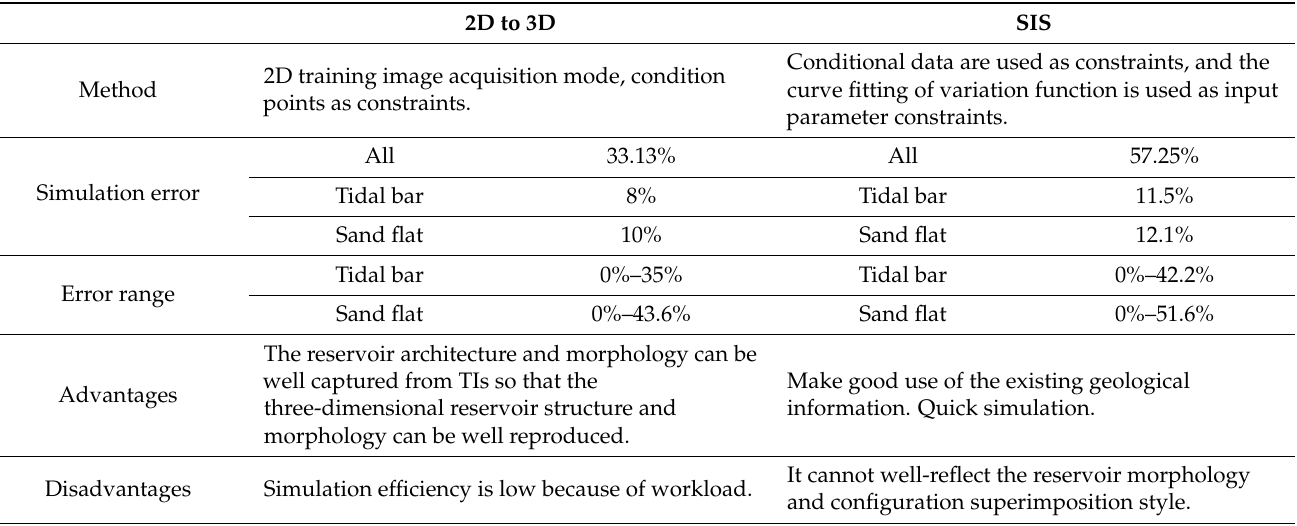
Table 1. Comparison of two methods (2D to 3D and